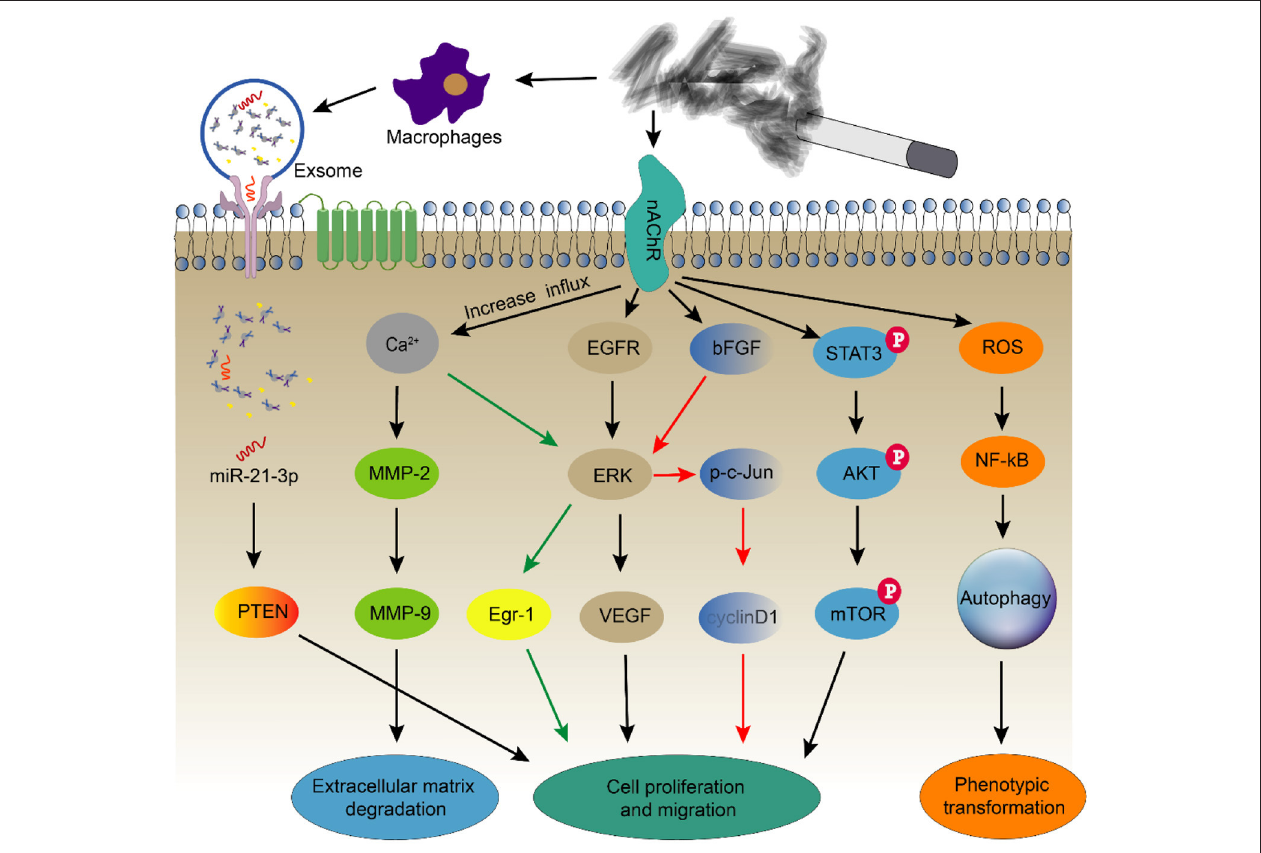
FIGURE 5 | Smoking alters the function and phenotype of smooth muscle cells. Smoking induces smooth muscle cell autophagy through oxidative stress and causes smooth muscle cell proliferation and migration through multiple signaling pathways. At the same time, it also regulates changes in the functions of smooth muscle cells by stimulating macrophages to secrete